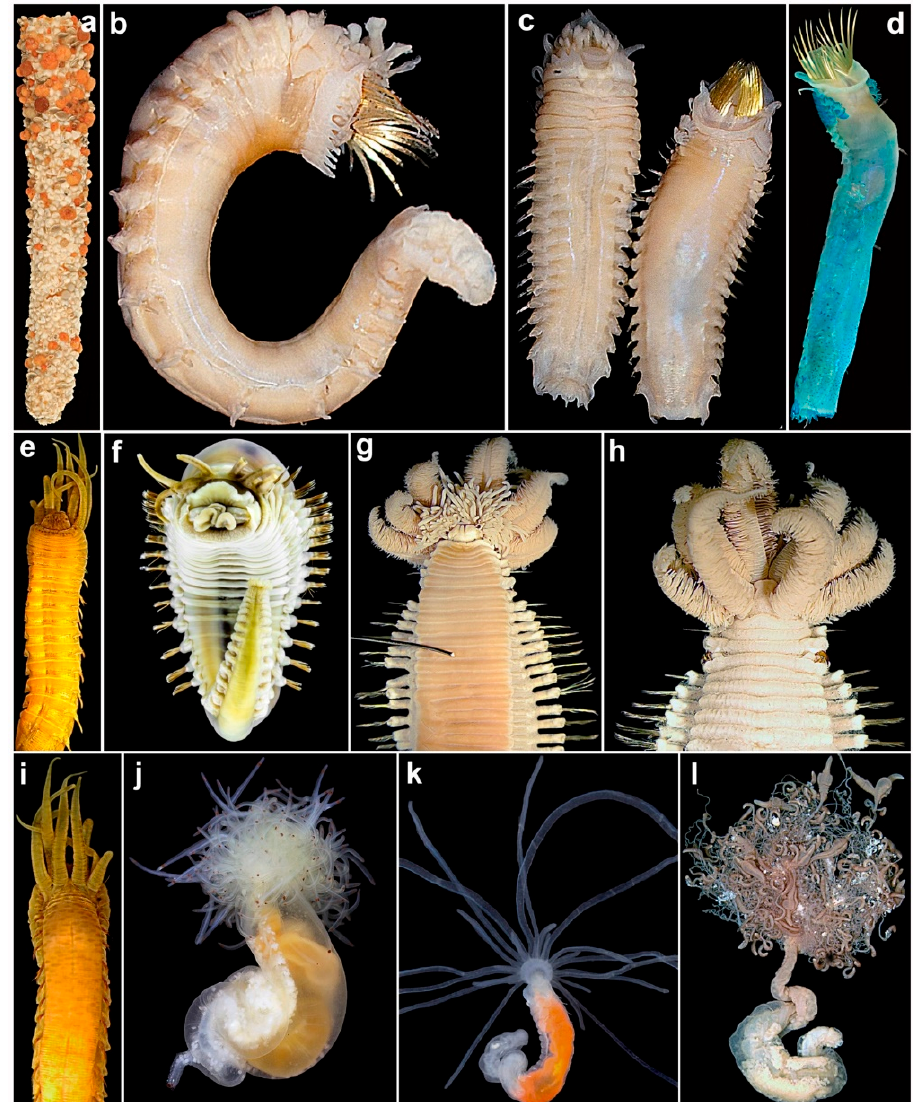
Figure 1. Diversity of Terebelliformia: Pectinariidae (PE), Ampharetidae (AM), Alvinellidae (AL) and Polycirridae (PO): ( a ) Petta investigatoris (PE), tube; ( b ) Amphictene auricoma (PE): entire worm, left lateral view; ( c ) Petta pusilla (PE): entire worms, ventral (left) and dorsal (right) views; ( d ) Petta investigatoris (PE): entire worm, dorsal view stained in methyl green; ( e , i ) Amphicteis dalmatica (paratype AM W.11667) (AM): anterior end, ventral and dorsal views, respectively; ( f ) Amythas membranifera (AM): entire worm, ventral view; ( g , h ) Alvinella pompejana (AM W.29585) (AL): anterior end, ventral and dorsal views, respectively; ( j ) Polycirrus oculeus (paratype AM W.44612) (PO): entire live worm, dorso-lateral view; ( k ) Polycirrus rubrointestinalis (PO): entire worm live, dorsal view; ( l ) Hauchiella tentaculata (holotype NTM W.023154) (PO): entire live worm, dorsal ventral view. Photos: ( d )—E. Wong; ( f )—Gabriel Monteiro; ( j – l )—A.